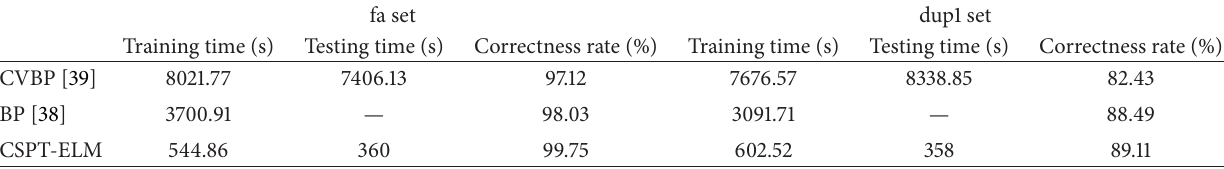
Table 7: Comparison of training time, testing time, and correctness of LCVBP, LBD, and LCSPT-ELM: the color FERET database. fa set dup1 set